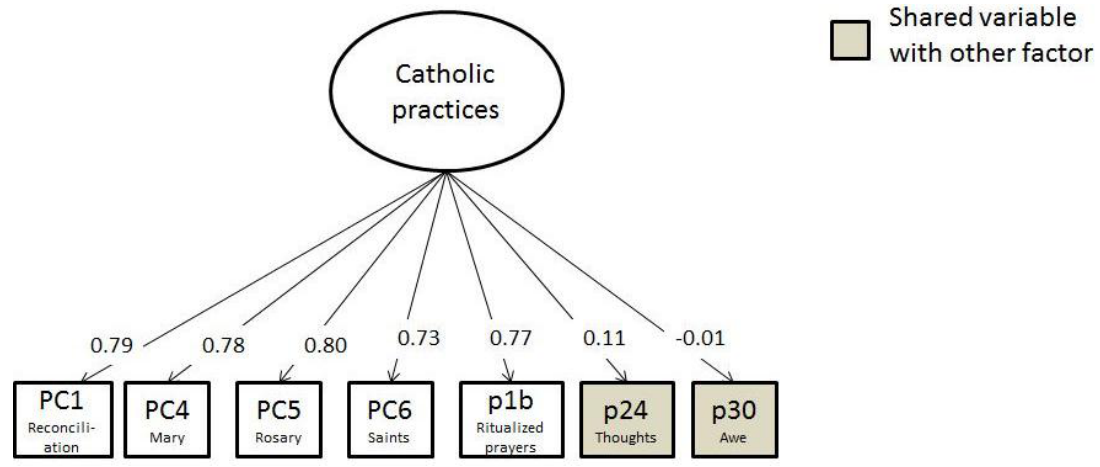
Figure 2. Factor Catholic practices from SEM.